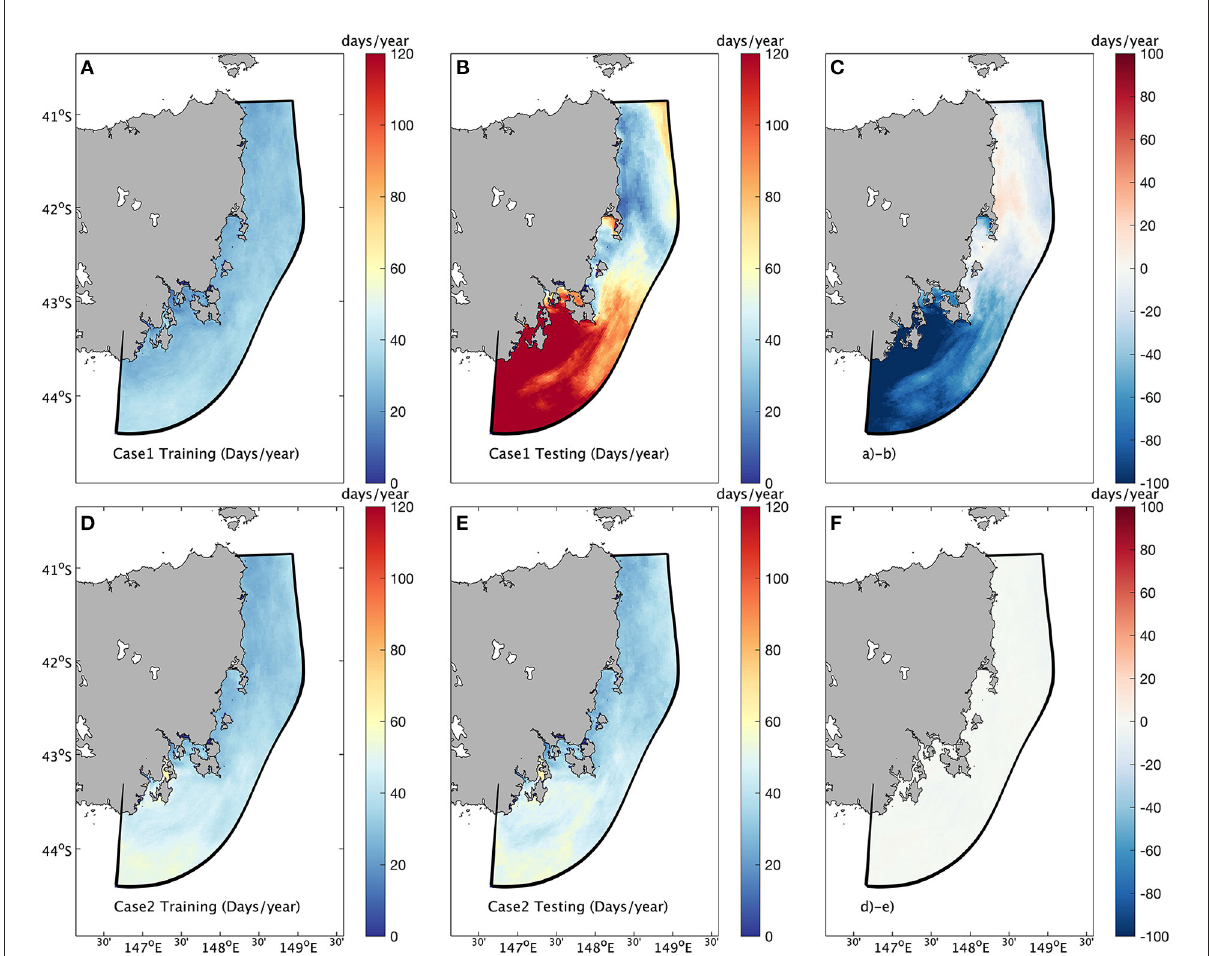
FIGURE9 The MHW days/year in training and testing data in each case. (A–C) separately indicate the MHW days/year in training data (1994–2011), MHW days/year in testing data (2012–2014), and the difference between training and testing data (A,B) in Case1. (D–F) separately indicate the MHW days/year in training data, MHW days/year in testing data (randomly selected time points equal to 3 leap years, 1098 days), and the difference between training and testing data (D,E) in Case